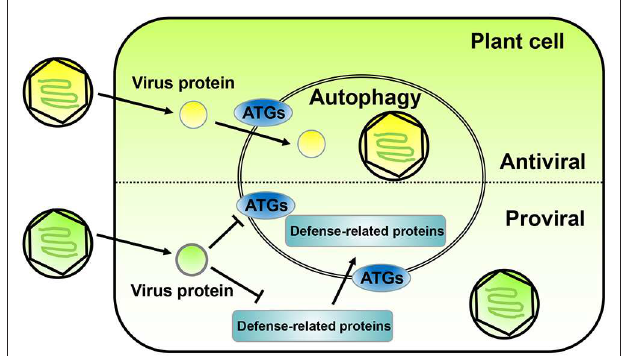
FIGURE 1 | The opposite roles of autophagy in plant-virus interaction. The diagram on the top shows an antiviral role for autophagy during plant infection by viruses. Plant viruses express proteins (yellow ball) to promote infection; however, sometimes the autophagy of the plant infected cell is activated and directly or indirectly targets the virus protein or vision toward degradation. The diagram on the bottom shows a proviral role for autophagy during plant infection by viruses. In some cases, plant virus proteins (green ball) can interact with ATGs to inhibit autophagy and prevent degradation. Also, some plant virus encoded proteins can promote the degradation of plant defense-related proteins through the autophagy pathway. Both case scenarios lead to an enhancement of viral replication and infection in the host